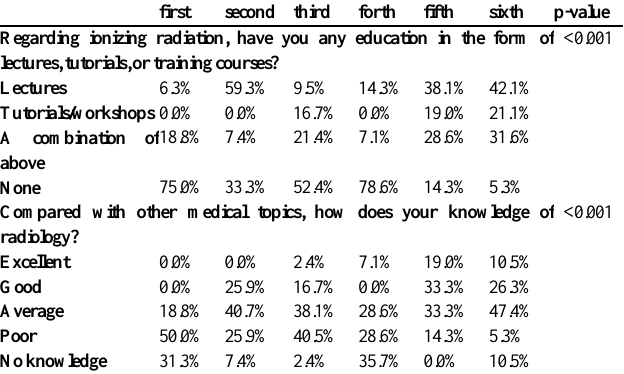
Table 2 : Self-estimation of awareness of radiology in